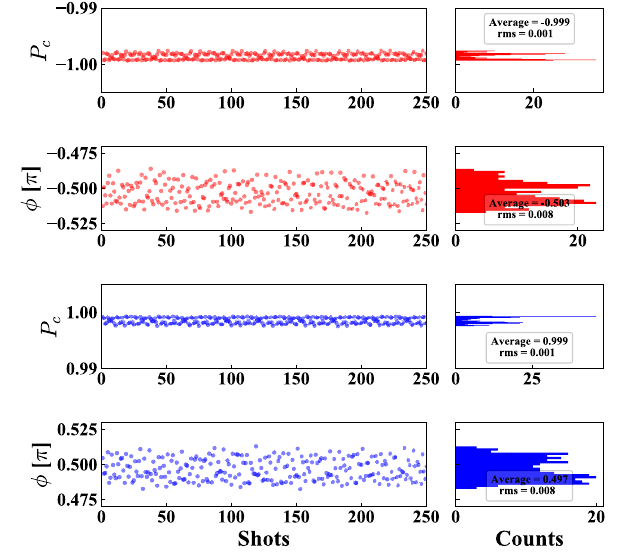
FIG. 5. P c and phase difference ϕ are shown when the phase shifter is tuned to left-hand circular and right-hand circular polarization. The histograms show the distribution of the data. The average polarization degree j P c j approach 99.9% with 0.1% RMS fluctuation. The histograms also show that the phase difference ϕ is